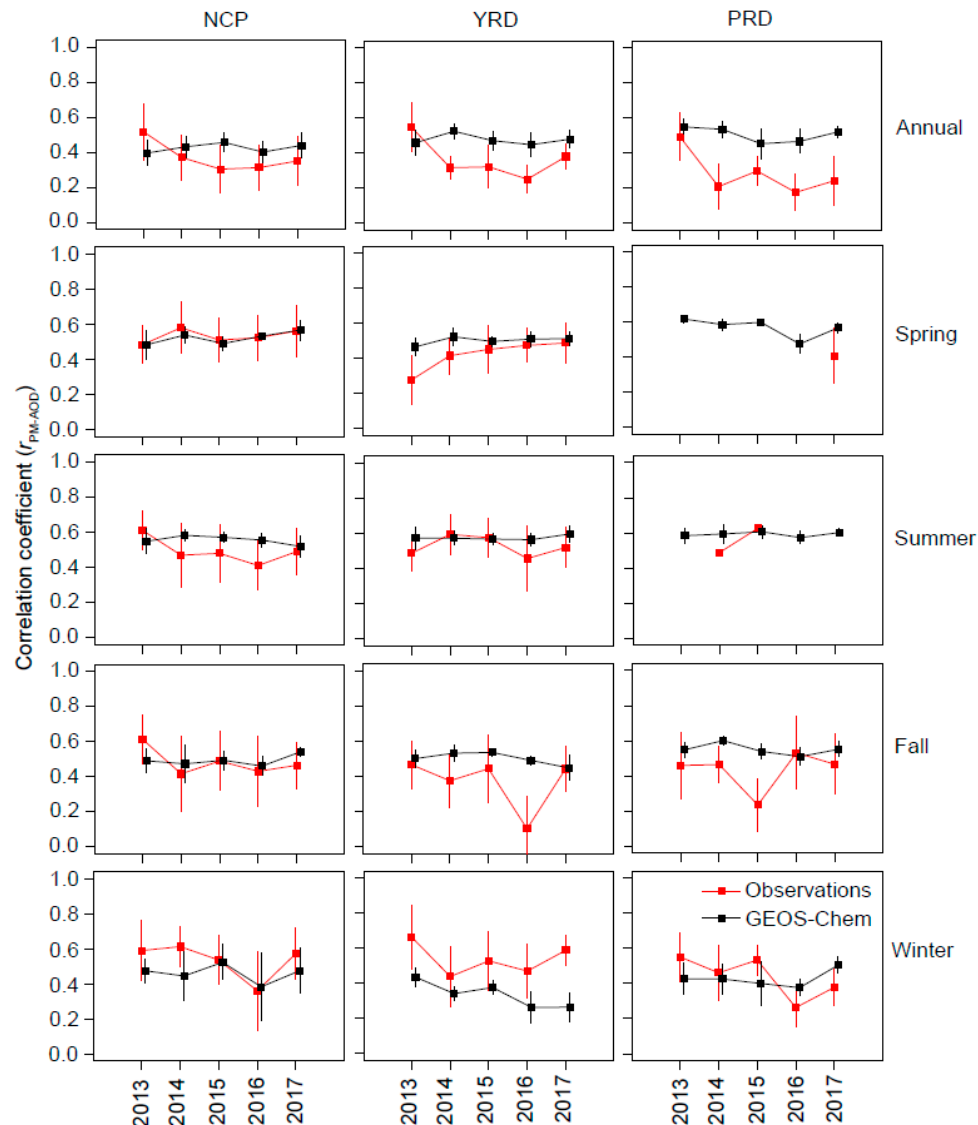
Figure 4. Observed (red lines) and GEOS-Chem simulated (black lines) annual and seasonal mean correlation coefficients of daily PM 2.5 and daily AOD ( r PM-AOD ) in NCP, YRD and PRD in 2013–2017. The bars are standard deviations.